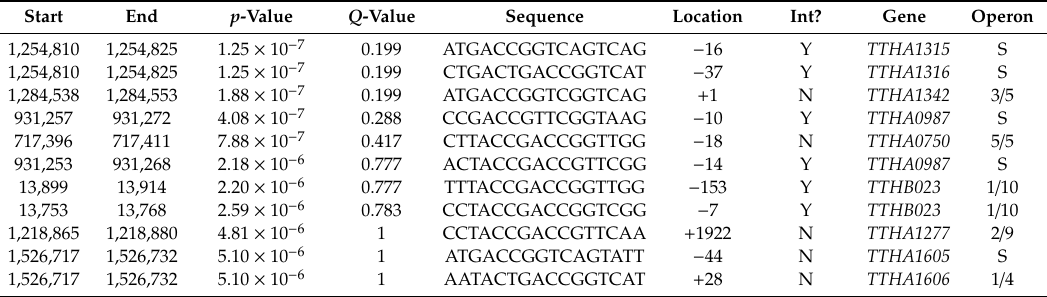
Table 2. TTHB023 consensus sequence sites within the T. thermophilus HB8